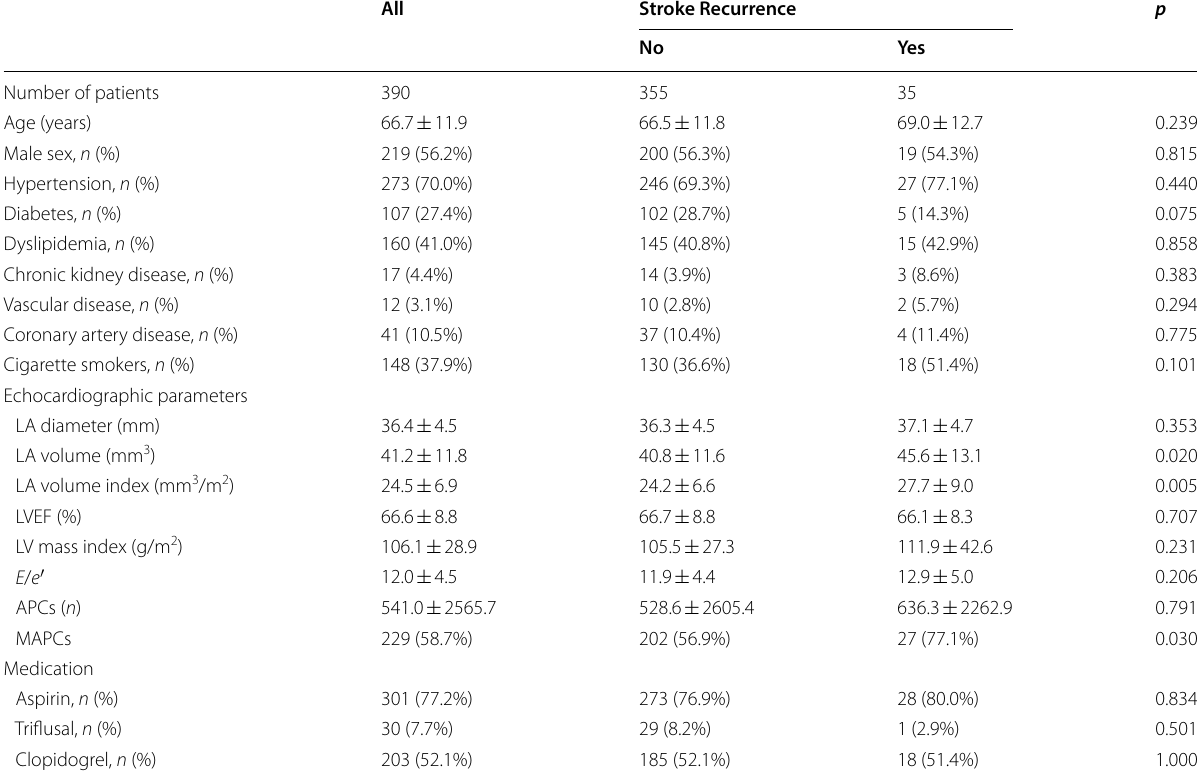
Table 1 Patient